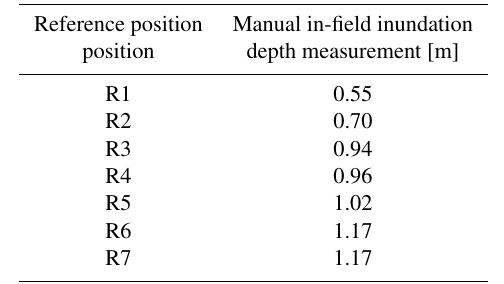
Table 1. Manual in-field inundation depth measurements at the seven reference positions at the study site, as given in Fig.